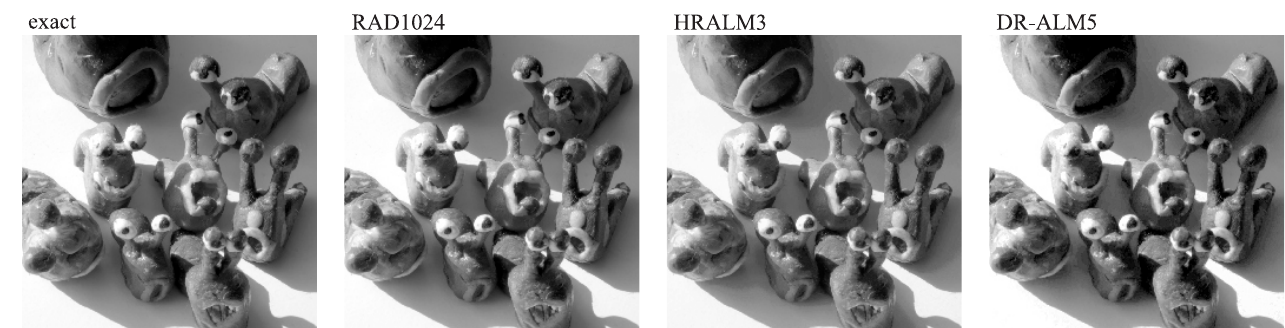
Figure 10. Lossy compression of the snails image with some approximate multipliers for the quality factor F = 50.